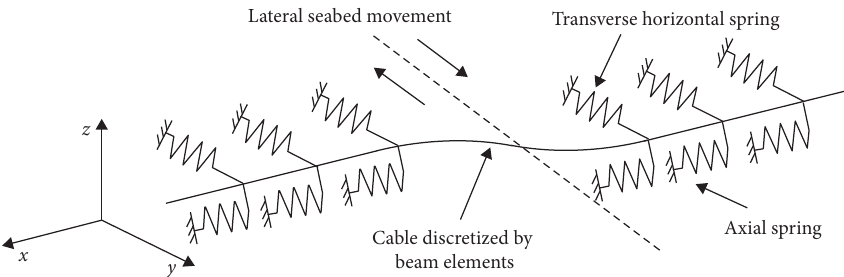
Figure 4: Finite element model of submarine telecommunication cable responses to lateral seabed